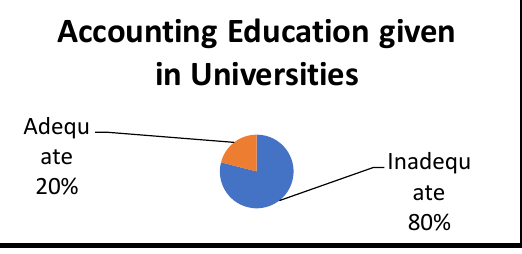
Figure 4. Accounting Education given in Universities Today’s business world has assigned several